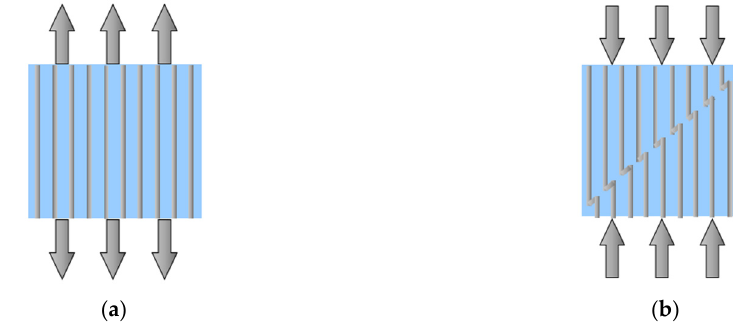
Figure 2. FRP bars: ( a ) Tension mode; ( b ) compression mode, failure by kinking of